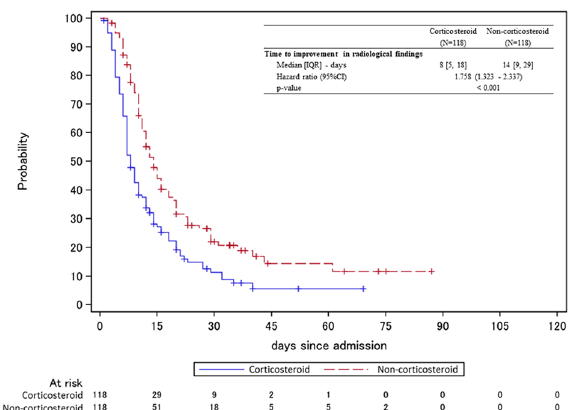
Figure 3. Time to Improvement in Radiological Findings. Kaplan–Meier curves for the time to improvement in radiological findings. Cox proportional hazards model was used to calculate the hazard ratio and its 95% confidence interval for the treatment effect between groups. IQR, interquartile ranges; CI, confidence interval.